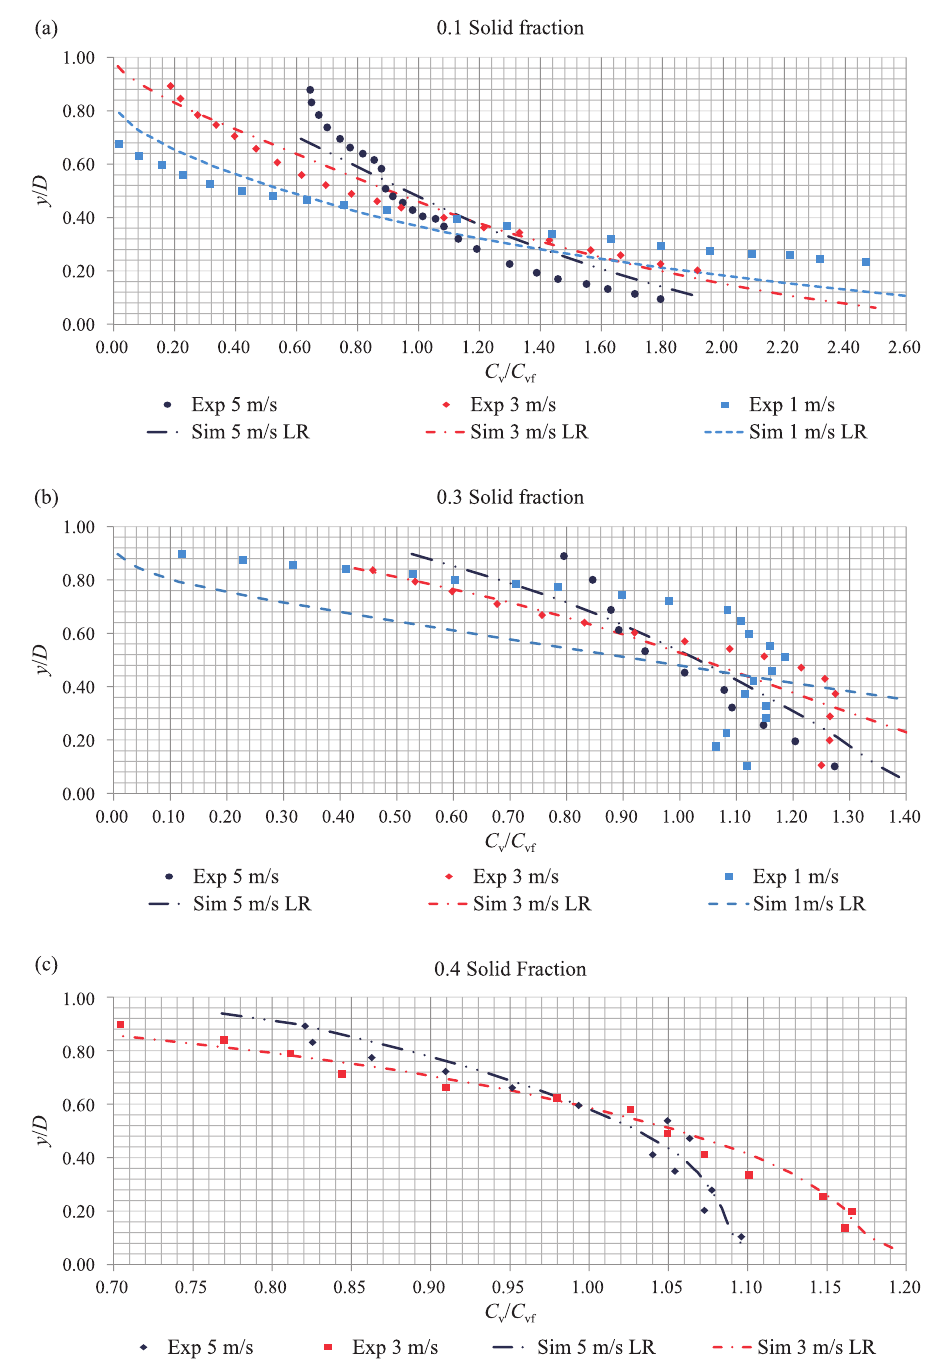
Fig. 2 Comparison of normalized (using the efflux volumetric fraction, C VF ) experimental and numerical (Mixture Model with the Low Reynolds k-ε Turbulence model) vertical solid concentration profiles for settling particles,